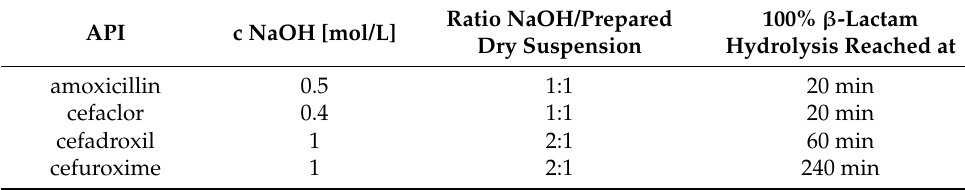
Table 2. Parameters for quantitative alkaline hydrolyzation of prepared β -lactam dry suspension formulations. For each API, three independent experiments were performed, yielding comparable 100% hydrolysis rates respectively.